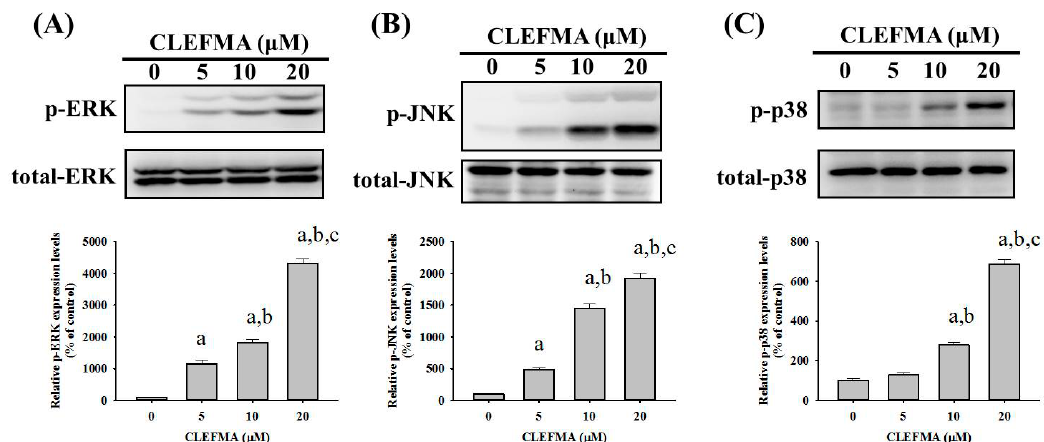
Figure 5. Effects of CLEFMA on the phosphorylation of ERK, c-Jun N-terminal kinases (JNK) and p38 in U2OS cells. Expressions of ERK1/2, JNK 1/2 and p38, as well as their phosphorylation after various concentrations (5, 10 and 20 μ M) of CLEFMA treatment for 24 h in U2OS cells, were measured through Western blot analysis. Next, they were subjected to quantitative analysis. Results are shown as mean ± S.D.; n = 3. ANOVA analysis with Turkey’s posteriori comparison was used. ( A ) p -ERK: F = 275.513, p < 0.001; ( B ) p-JNK: F = 205.474, p < 0.001; and ( C ) p = p38: F = 292.128, p < 0.001. a: Significantly different, p < 0.05, when compared to control. B: Significantly different, p < 0.05, when compared to 5 μ M. c: Significantly different, p < 0.05, when compared to 10 μ M.